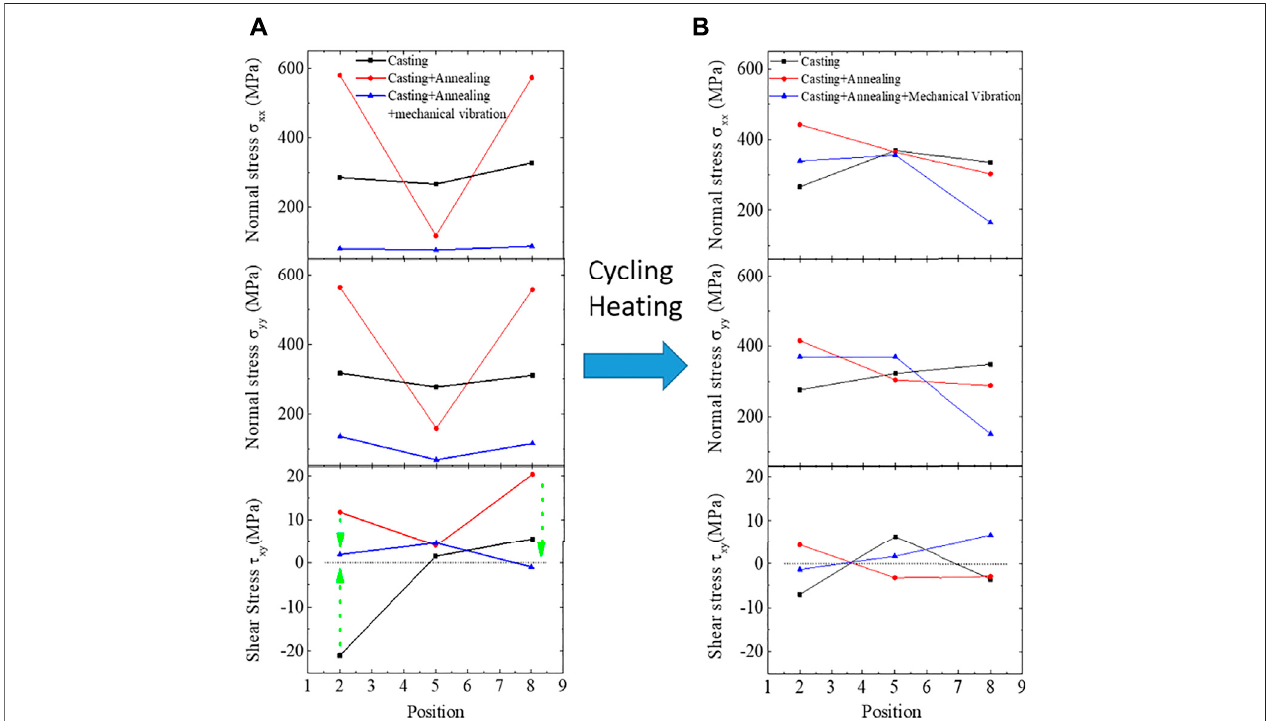
FIGURE 3 | Residual stresses at points 2, 5, and 8 of the stress frames (A) Initial stress, (B) Stress after cyclic heating.